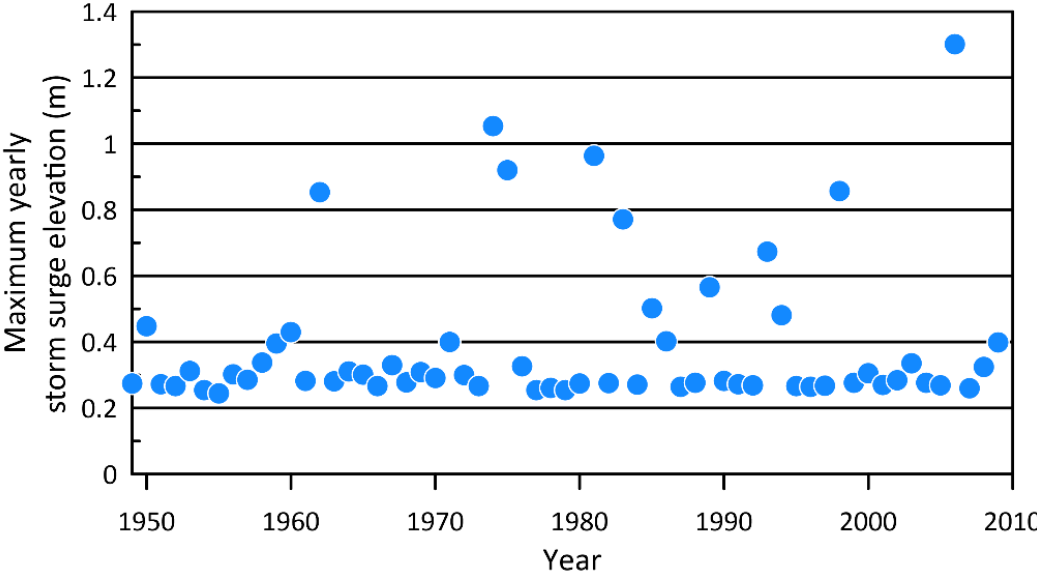
Figure 7. Yearly maximum values of storm surge obtained from Equation (1).